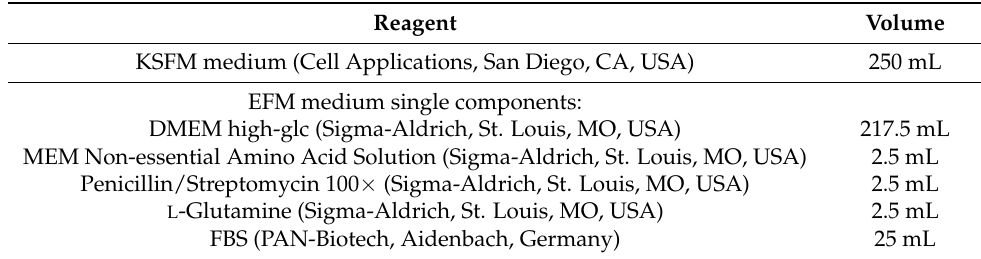
Table 2. Composition and formula of the proliferation